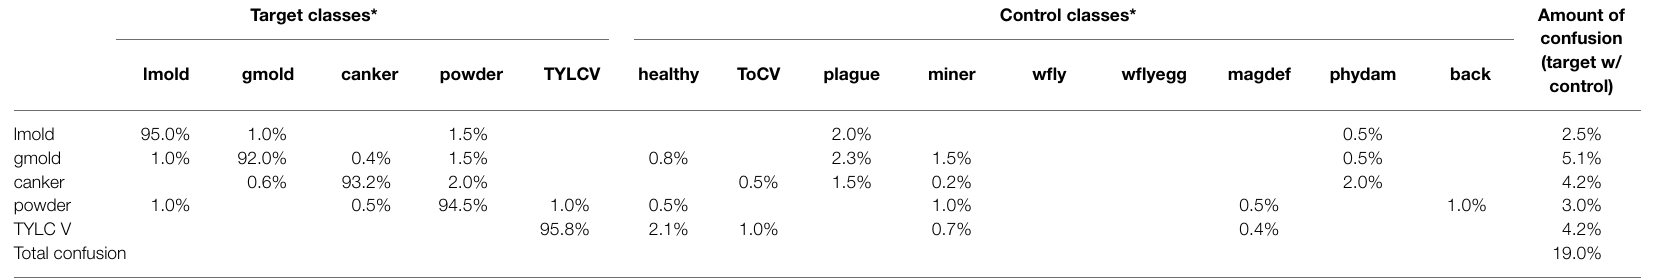
TABLE 6 | Confusion matrix of target classes using control classes for